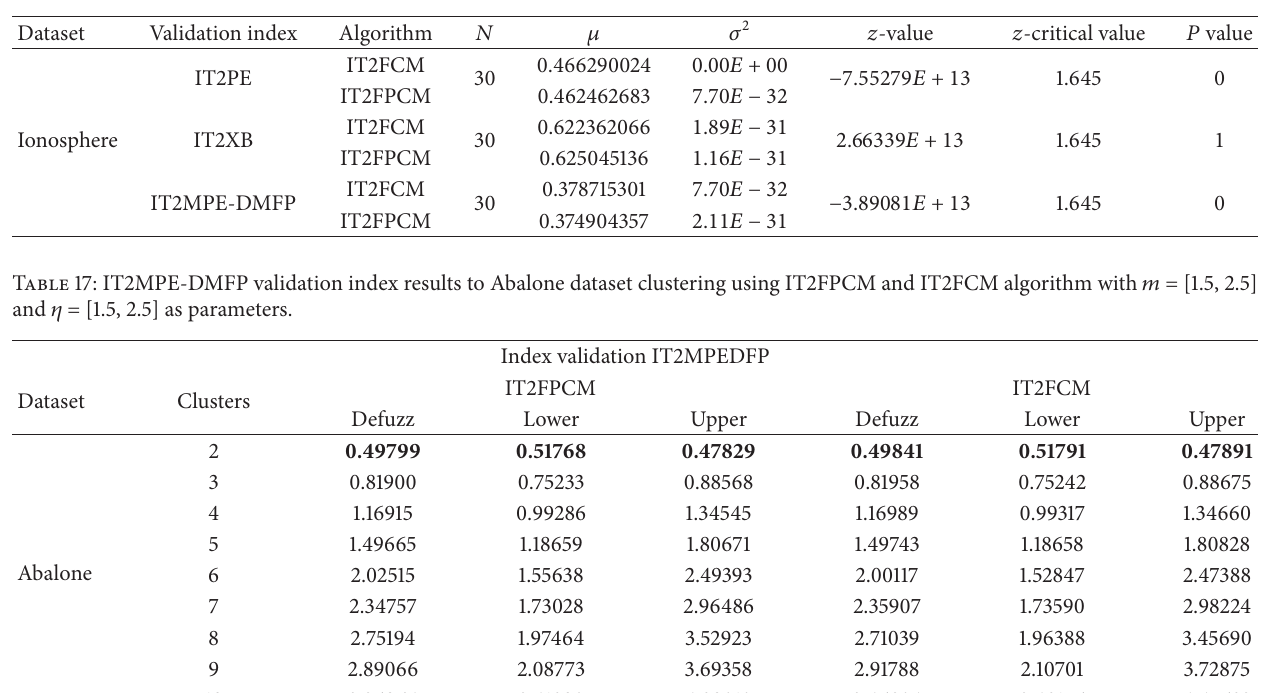
Table 16: Hypothesis test for IT2PE, IT2XB, and IT2MPE-DMFP indices of validation for the Ionosphere dataset clustering.